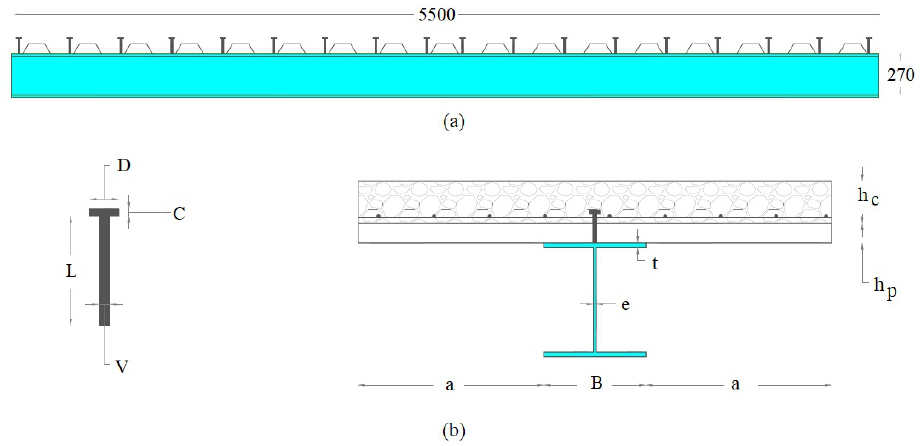
Figure 2. Geometry of composite system: ( a ) length and height of the section; ( b ) beam cross-section and stud anchor. Unit: